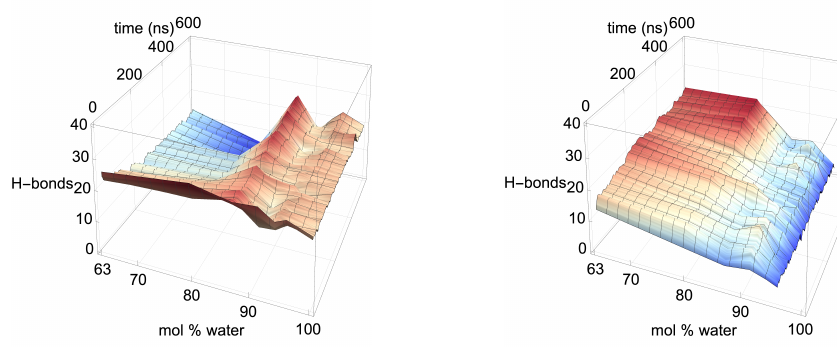
Figure A12. Cont